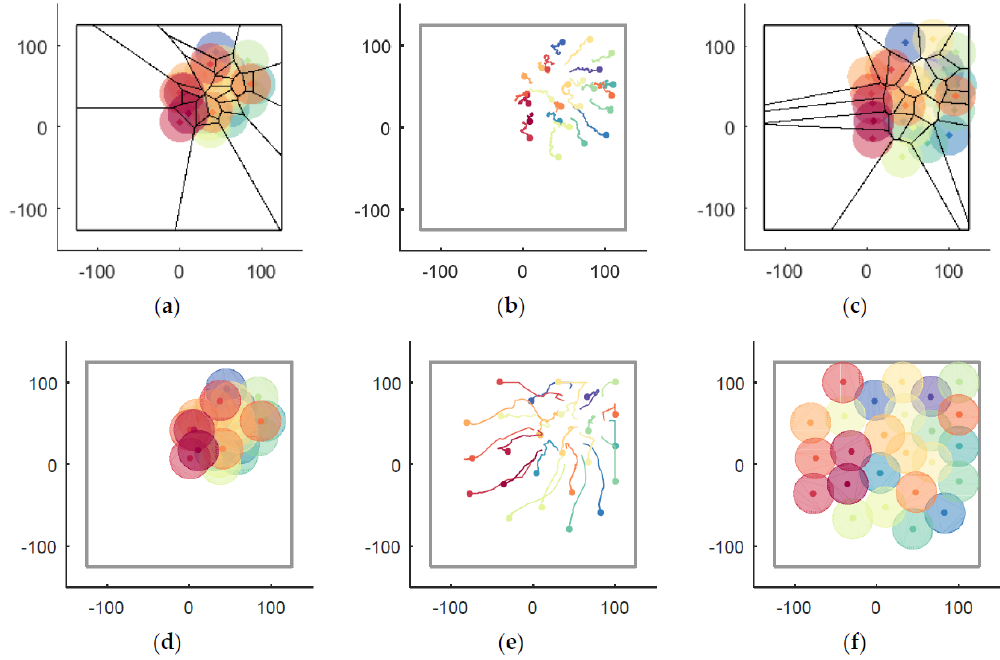
Figure 17. The coverage situations of the V-based and VFA methods. ( a ) The V-based coverage ( k = 0); ( b ) The recorded trajectories of UAVs by the V-based method ( k = 0 ∼ 574); ( c ) The V-based coverage at k = 574; ( d ) The VFA coverage ( k = 0); ( e ) The recorded trajectories of UAVs by the VFA method ( k = 0 ∼ 574); ( f ) The VFA coverage at k =